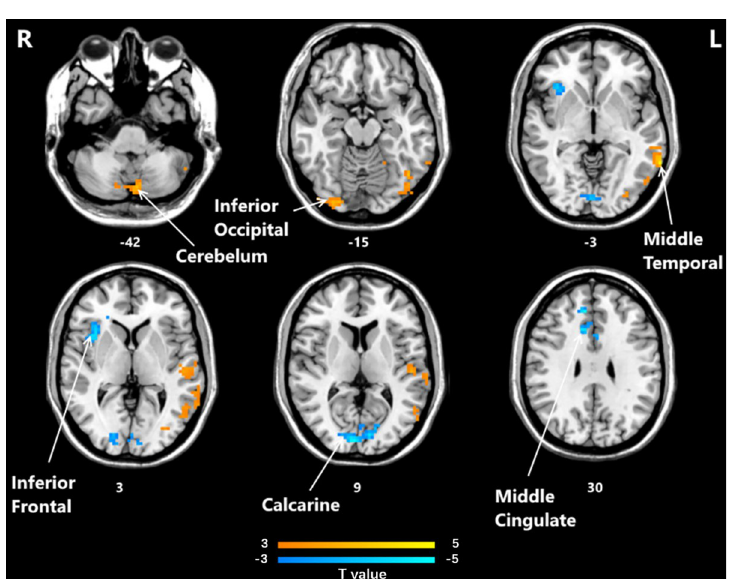
Fig 3. Brain regions that showed significant alterations in fALFF values before and after sham stimulation. (P < 0.05, AlphaSim corrected). The yellow color denotes post-sham-HD-tDCS > pre-sham-HD-tDCS in the fALFF values and the blue color denotes post-sham-HD-tDCS < pre-sham-HD-tDCS. The T-value bars are shown at the bottom. The brain regions with significant increases in fALFF include Frontal Inf Oper R, Calcarine R, Cingulum Mid R. However, Cerebellum 7b L, Temporal Mid L, Cerebellum Crus1 L, Occipital Inf R, and Postcentral L decreased significantly. fALFF, fractional amplitude of low-frequency fluctuation; HD-tDCS, high-definition transcranial direct current